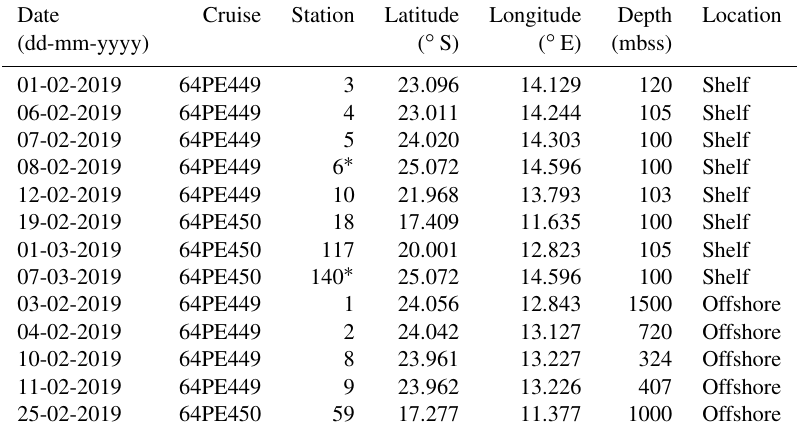
Table 1. Sampling date, cruise name, station label, coordinates and sediment depth (mbss) during expeditions 64PE449 and 64PE450. Stations are grouped according to location type and listed based on their sampling date. Location type is “shelf” when sediment depth is < 120mbss or “offshore” when sediment depth is >